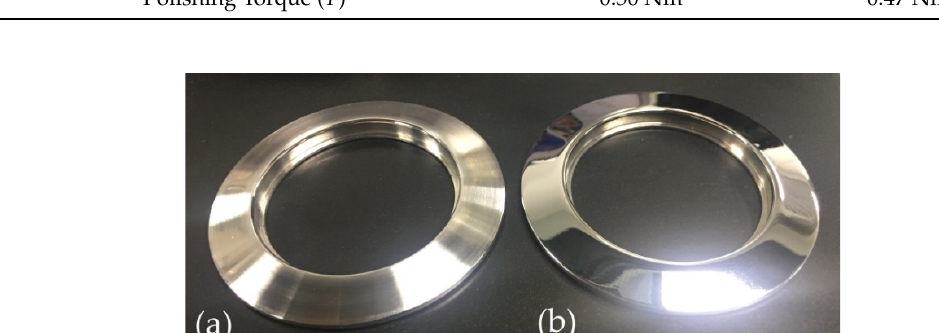
Figure 9. Watch bezel: ( a ) before polishing and ( b ) after robotic polishing.